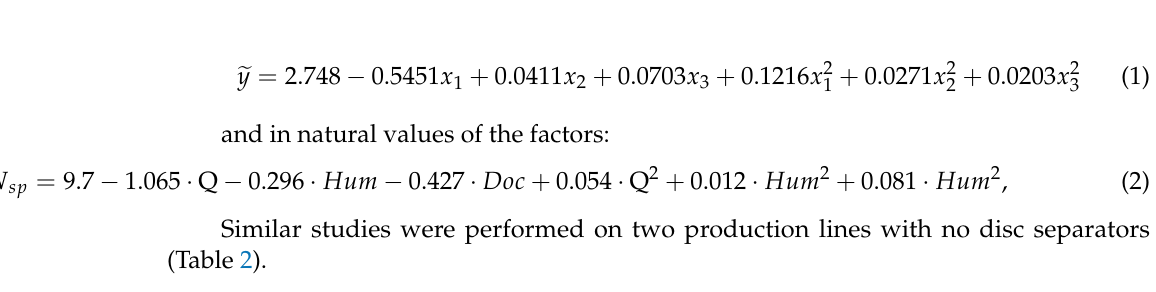
Table 2. Factor levels and factor variability intervals for ZAV-20 (two production lines without disc separators). Levels